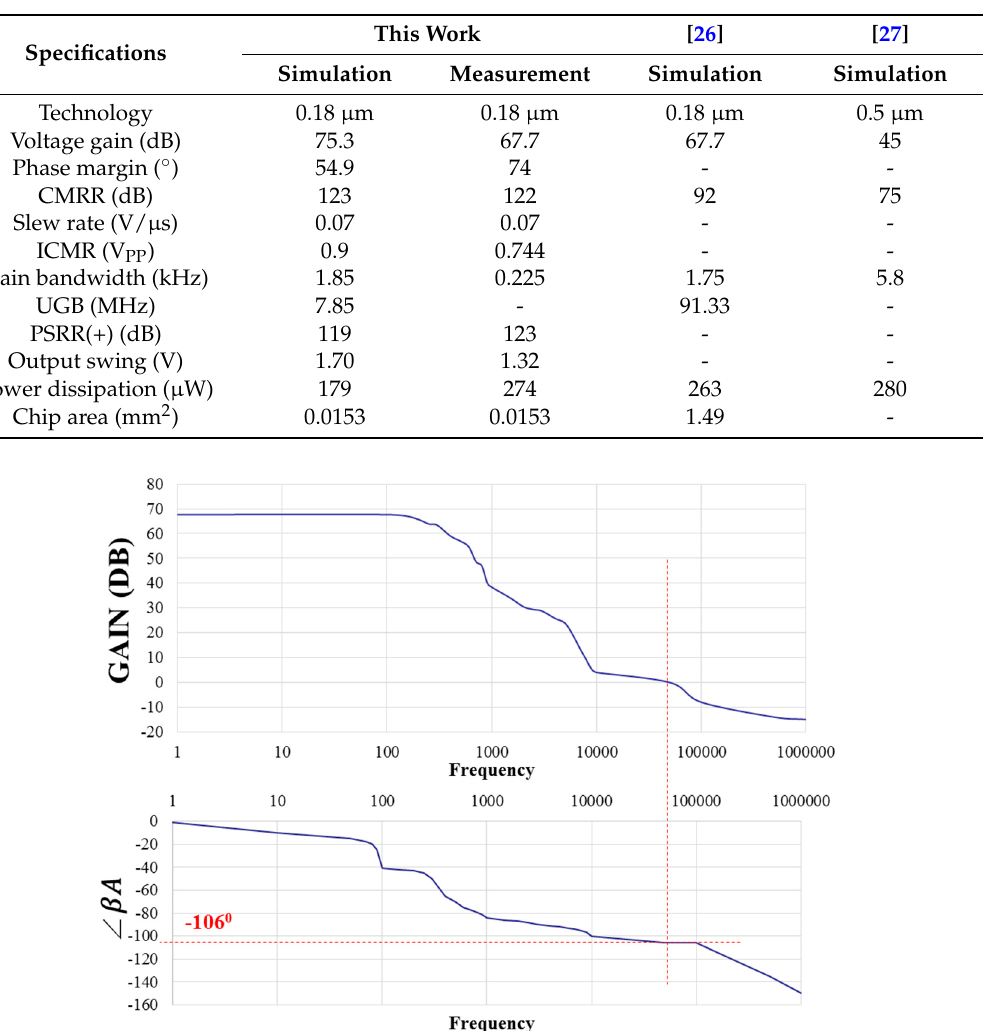
Table 1. Comparison of simulated and measured results of amplifier with results of previous designs.